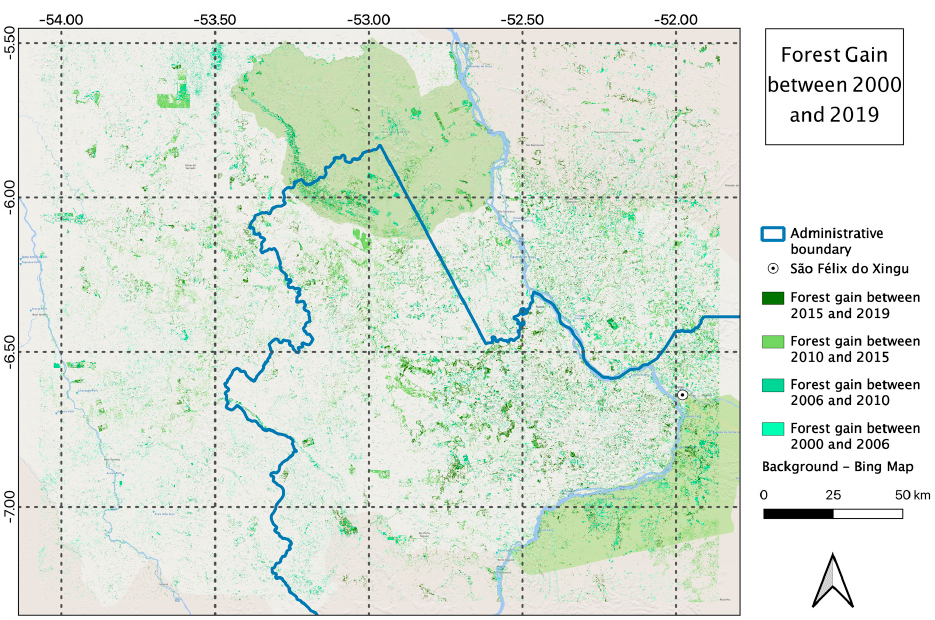
Figure 7. Cumulative forest gain from 2000 to